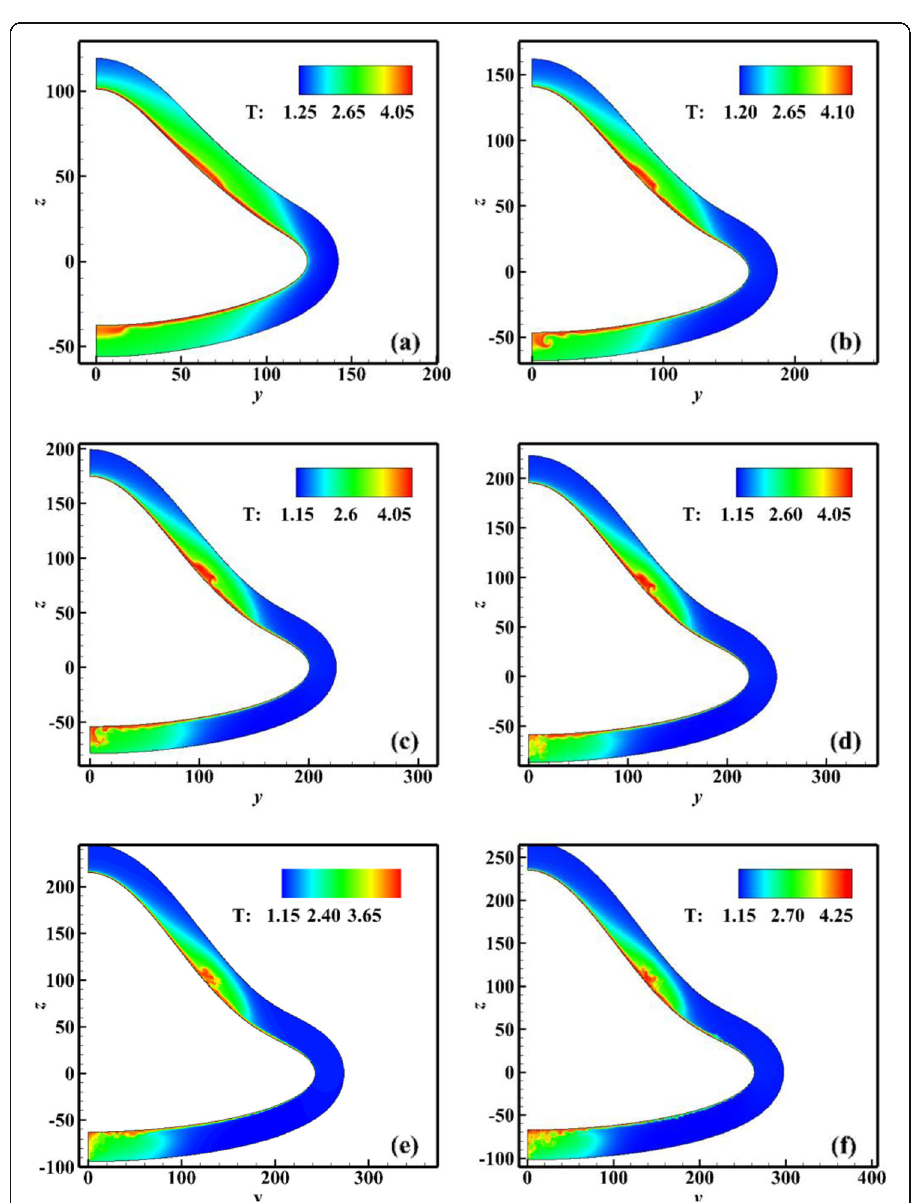
Fig. 10 Contour of the instantaneous temperature at different streamwise positions ( a ) x = 529 mm, ( b ) x = 779 mm, ( c ) x = 994 mm, ( d ) x = 1124 mm, ( e ) x = 1249 mm, ( f ) x = 1374